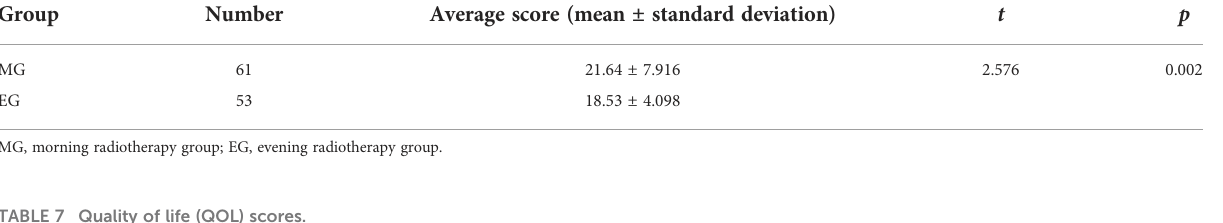
TABLE 6 M.D. Anderson Symptom Inventory scores. Group